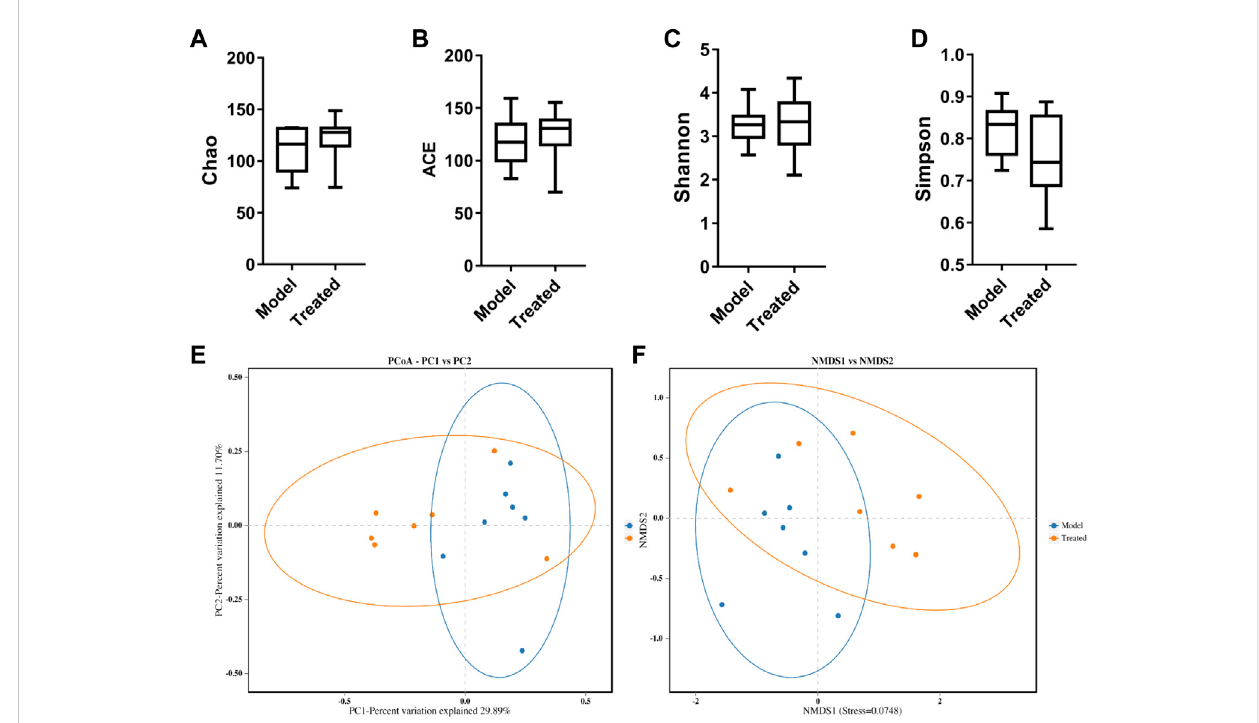
FIGURE 9 Alpha-diversity and beta-diversity analysis on the intestinal microbiota of piglets. (A) Chao, (B) ACE, (C) Shannon, and (D) Simpson indexes calculated after rarefying to an equal number of sequence reads for all samples. Data are represented as box plots. (E) PCoA of the intestinal microbiota of 10-day-old piglets in differentgroups.Thebluedotsrepresentedthemodelgroup,andtheorangedotsrepresentedthetreatedgroup. (F) NMSDoftheintestinalmicrobiotaof10-day-old piglets in different groups. Model represents piglets challenged with PEDV, and treated represents piglets received an oral administration of HJ before PEDV challenged.Dotsofthesamecolorindicatethattheybelongtothesamegroup.Thecloserthedotswere,themoresimilarthecompositionofthesampleswas, n =7.